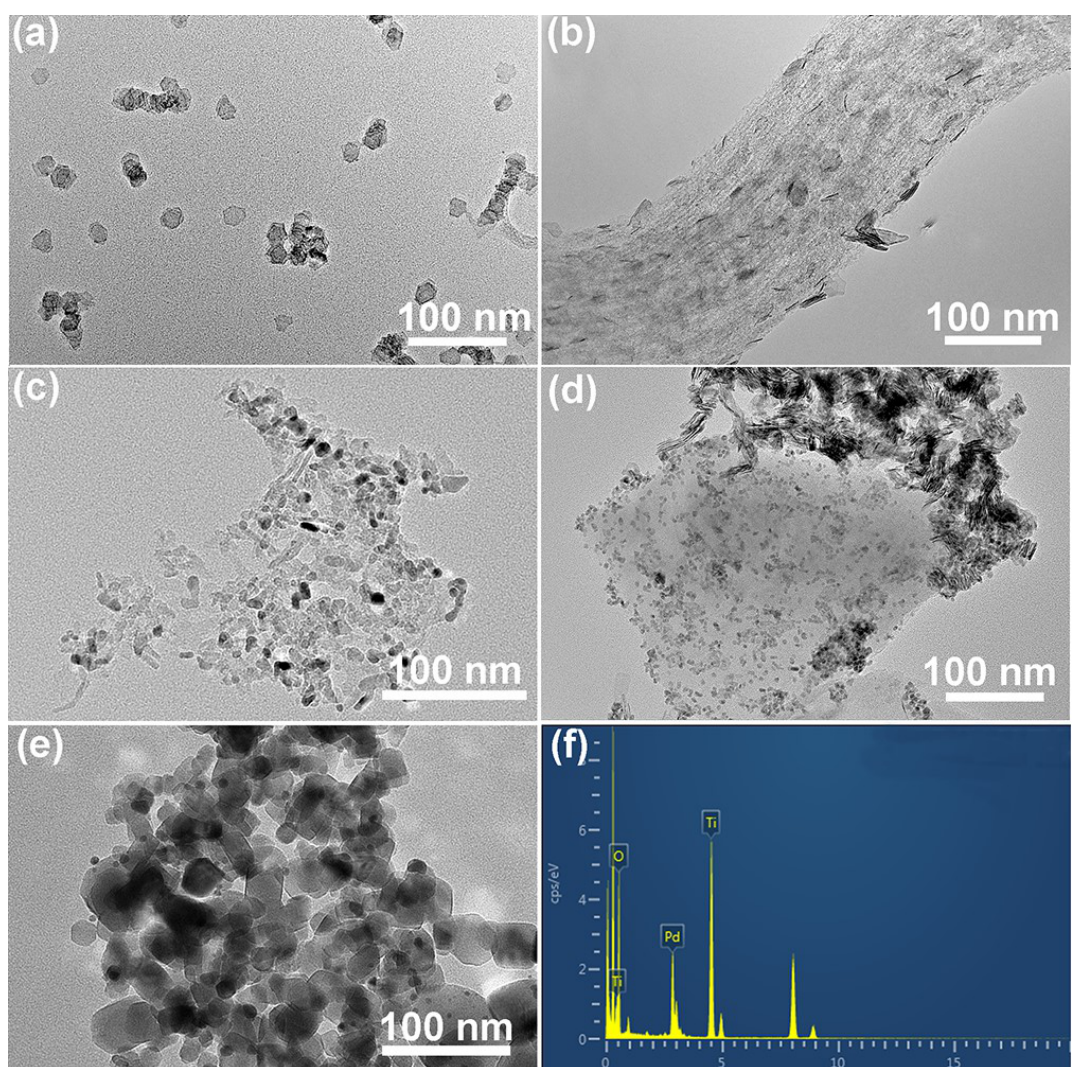
Figure 3. TEM images of ( a ) Pd nanosheets obtained in the absence of P25 support, ( b , c , d )